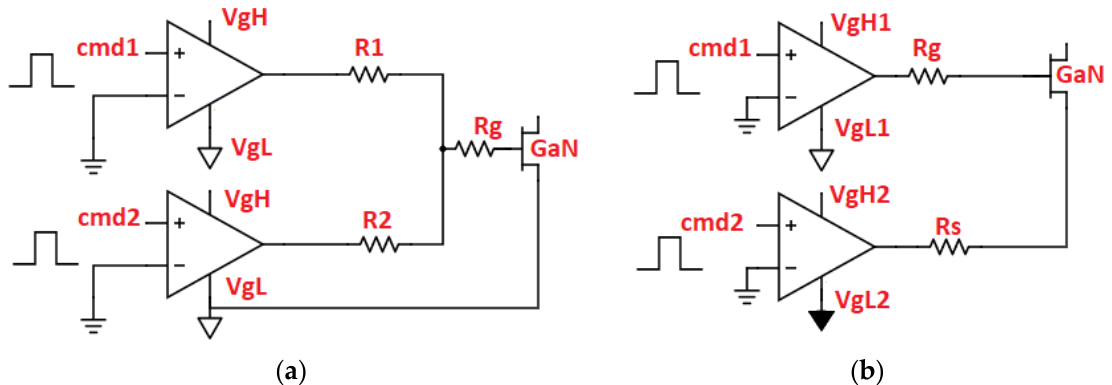
Figure 3. Possible gate drive circuit configurations for AGVC: ( a ) configuration-1 with a common-voltage at the source, ( b ) configuration-2 with a varying voltage at the source.